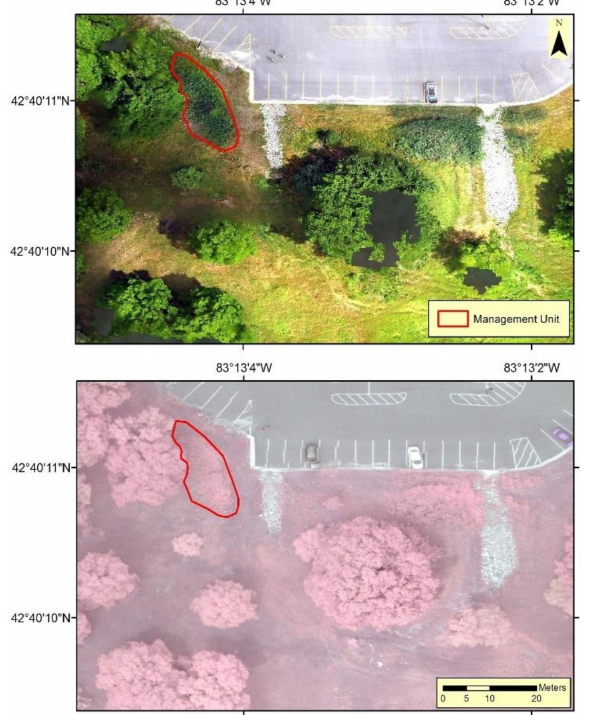
Figure 4. Overview imagery of management site 129. DJI Phantom 3 optical RGB (top) and MAPIR near infrared false color composite (bottom)